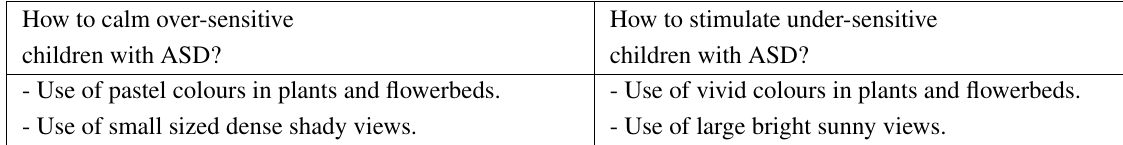
Table 13. How to use views in creating specific influences (Wilson,